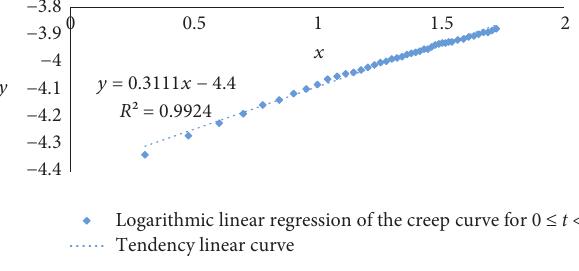
Figure 18: Logarithmic linear regression curve of creep in the . interval 0 ≤ t < t 1 Table 10: MF parameters for specimen creep AF11(Ø54) under σ � 16 . 1865MPa.